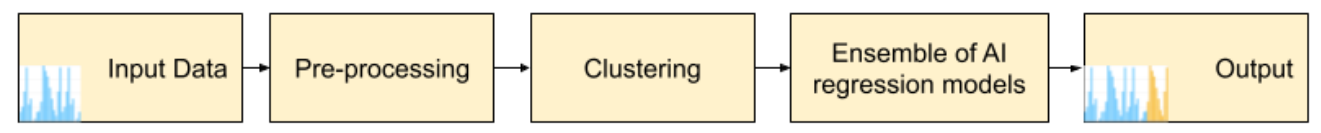
Figure 2. Proposed framework to determine adherence to training in the MH fitness app.